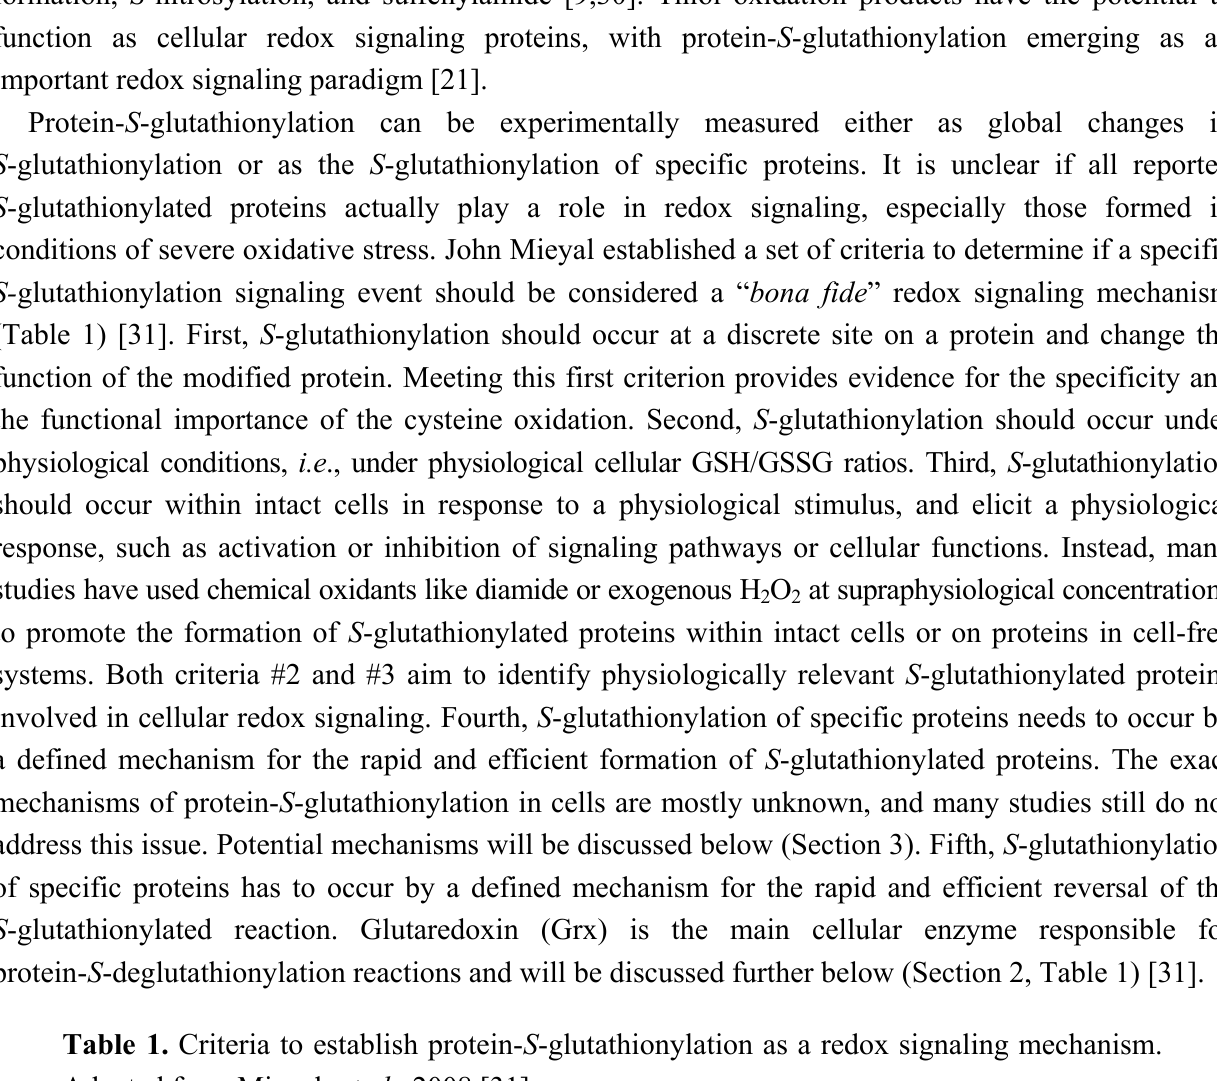
Table 1. Criteria to establish protein- S -glutathionylation as a redox signaling mechanism. Adapted from Mieyal, et al. , 2008